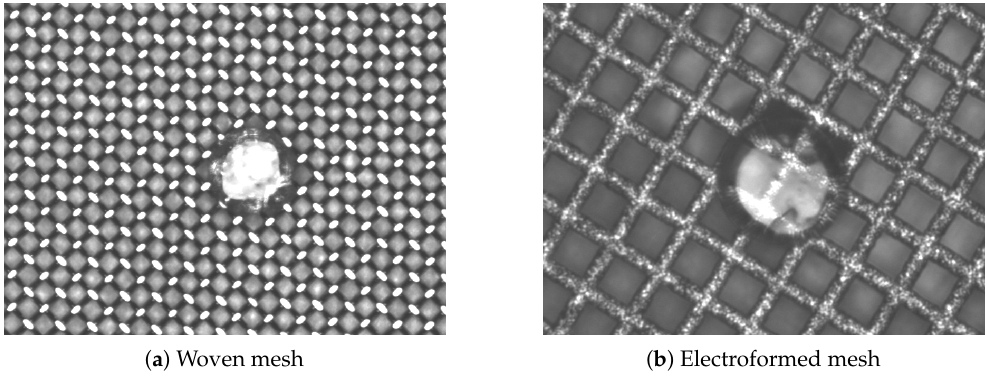
Figure 2. Microscopic pictures of ( a ) woven inox mesh and ( b ) electroformed “thinmesh”. Both Micromegas are produced in the bulk technique, and a pillar is shown in the center of the